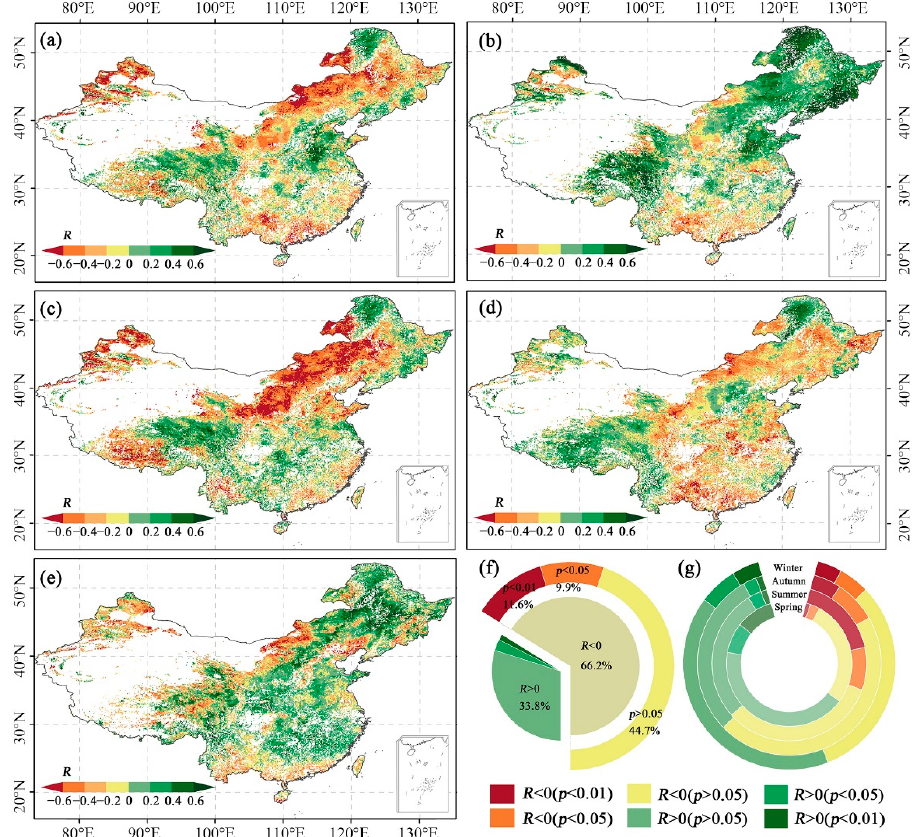
Figure 7. Spatial distribution of the correlation coefficients ( R ) between gross primary productivity (GPP) and vapor pressure deficit (VPD) across China under ( a ) annual and seasonal temporal scales including ( b ) spring, ( c ) summer, ( d ) autumn, and ( e ) winter from 2001 to 2020, and ( f ) annual and ( g ) seasonal frequency distribution of correlation coefficients ( R ) between GPP and VPD.